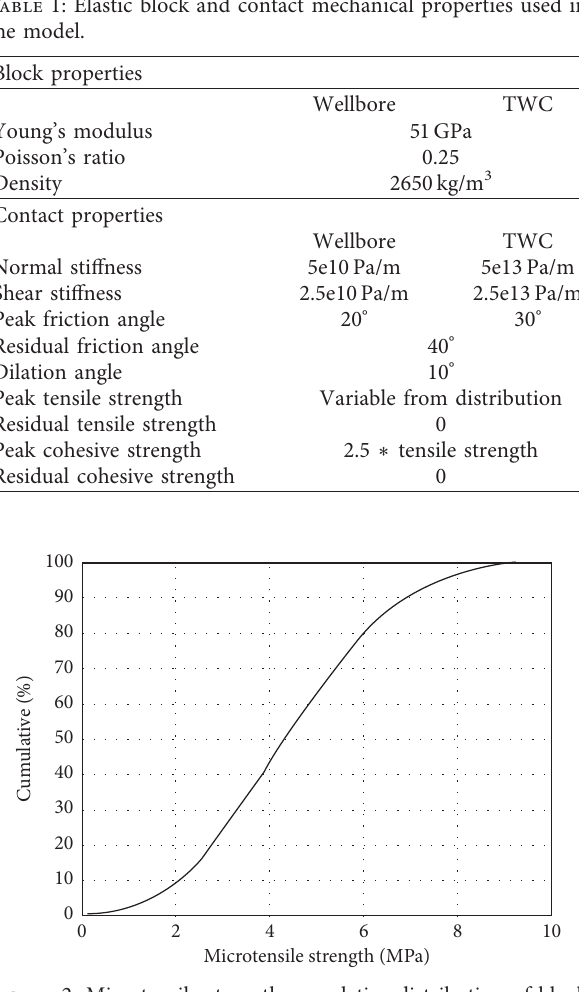
Figure 2: Microtensile strength cumulative distribution of block contacts.